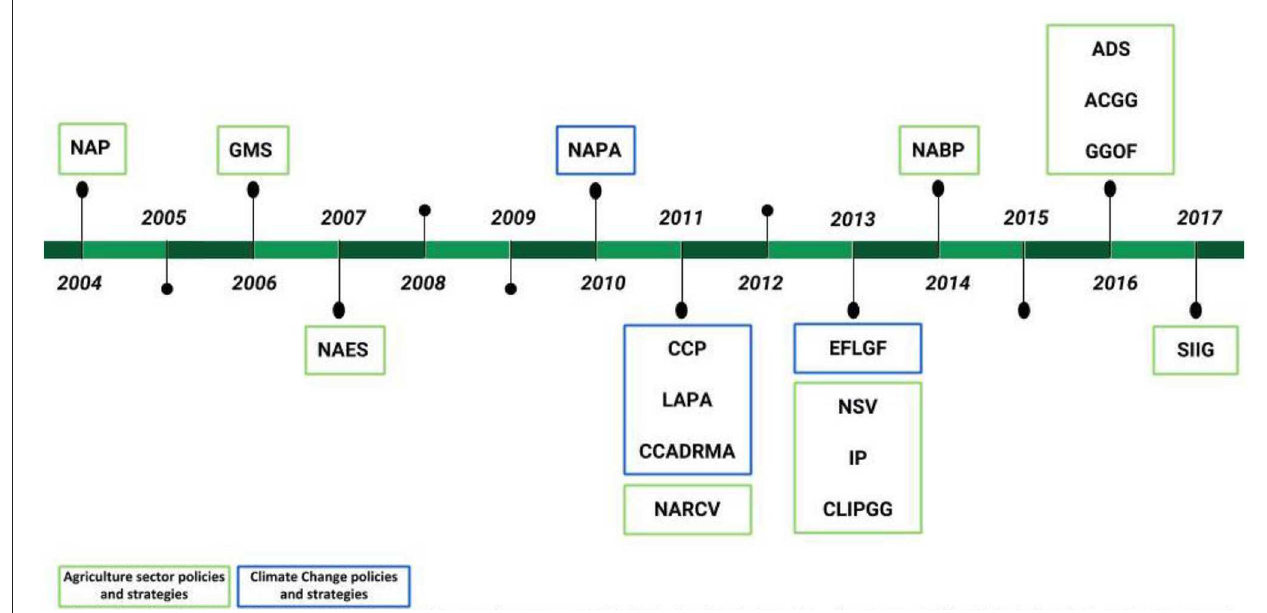
FIGURE 2 | Climate change and agricultural policies and strategies adopted between 2004–2017 in Nepal. NAP, National Agriculture Policy 2004; GMS, Gender Mainstreaming Strategy 2006; NAES, Nepa1 Agriculture Extension Strategy 2007; NAPA, National Adaptation Program of Action to Climate Change 2010; CCP, Climate Change Policy 2011; LAPA, National Framework on Local Adaptation Plans for Action 2011; CCADRMA, Ciimate Change Adaptation and Disaster Risk Management in Agriculture: Priority framework for action 2011–2020; NARCV, National Agricultural Research Centre (NARC) Vision; NSV, National Seed Vision 2013–2025; IP, Irigation Policy (revised) 2013; CLIPGG, Crop and Livestock Insurance Premium Grant Guideline 2013; EFLGF, Environment Friendly Local Government Framework 2013; NABP, National Agro Biodiversity Policy 2006 (revised 2014); ADS, Agriculture Development Strategy ADS 2015–2035;